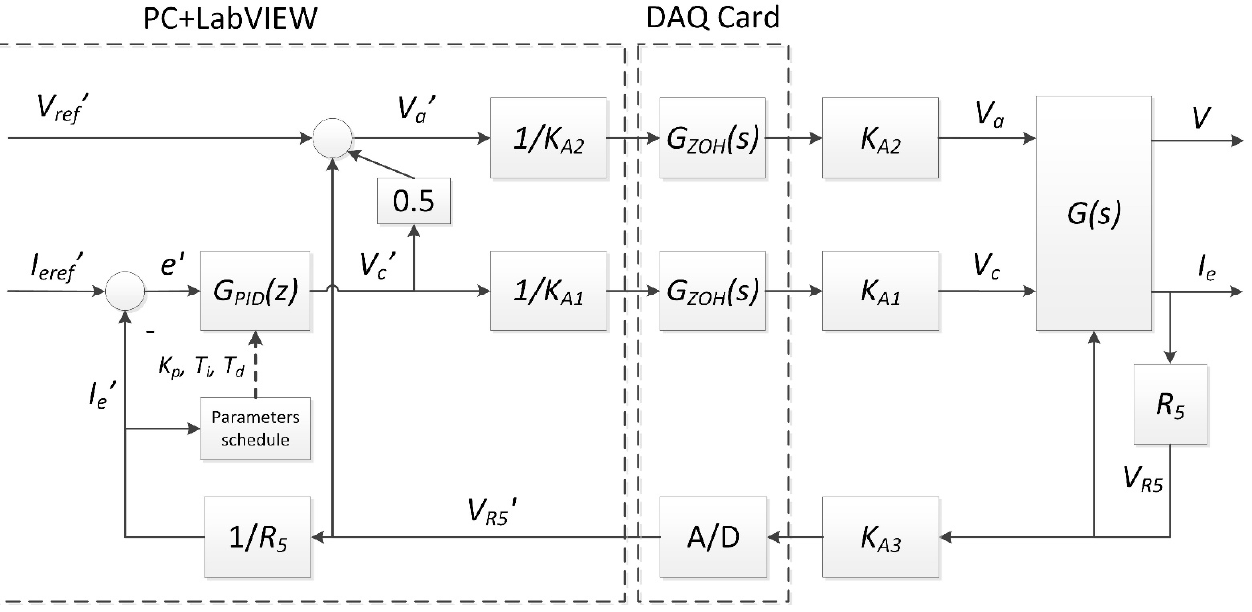
Figure 2. A block diagram of the designed control system.